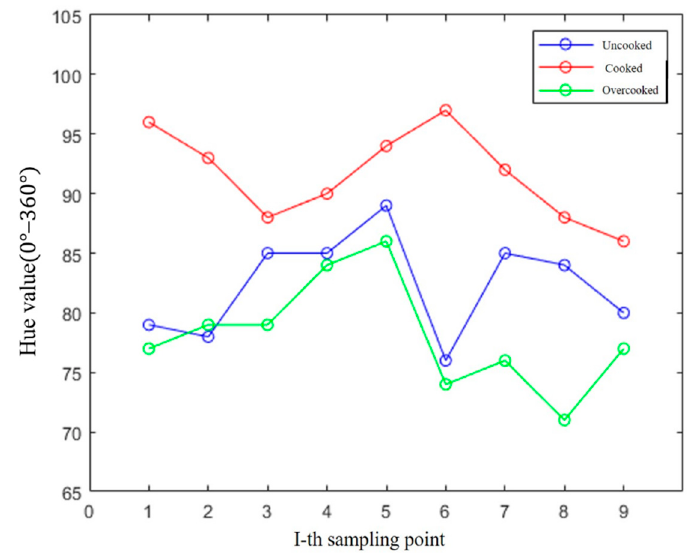
Figure 10. The hue value changes of nine marking points.